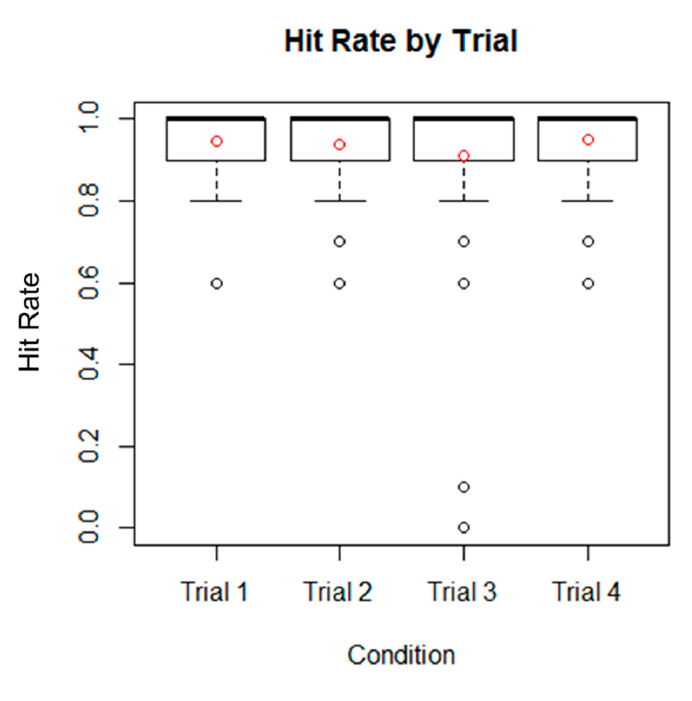
Figure 9. Hit rate by trial.